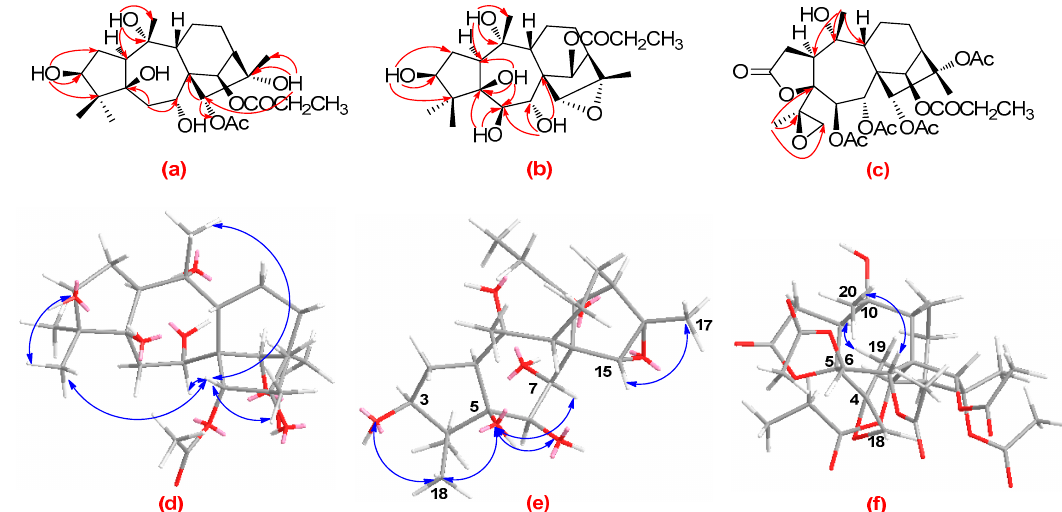
Figure 3. ( a )–( c ) are key HMBC correlations of pierisoids C–E, respectively; ( d )–( f ) are selected ROESY Figure 3. ( a ) − ( c ) are key HMBC correlations of pierisoids C − E, respectively; ( d ) − ( f ) are selected ROESY correlations of pierisoids C–E, respectively. correlations of pierisoids C − E, respectively.